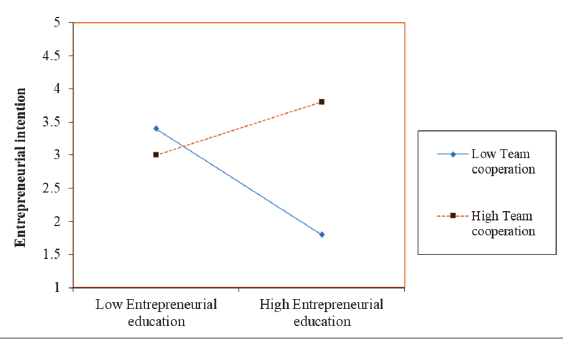
Fig. 6. The regulatory role of Team cooperation